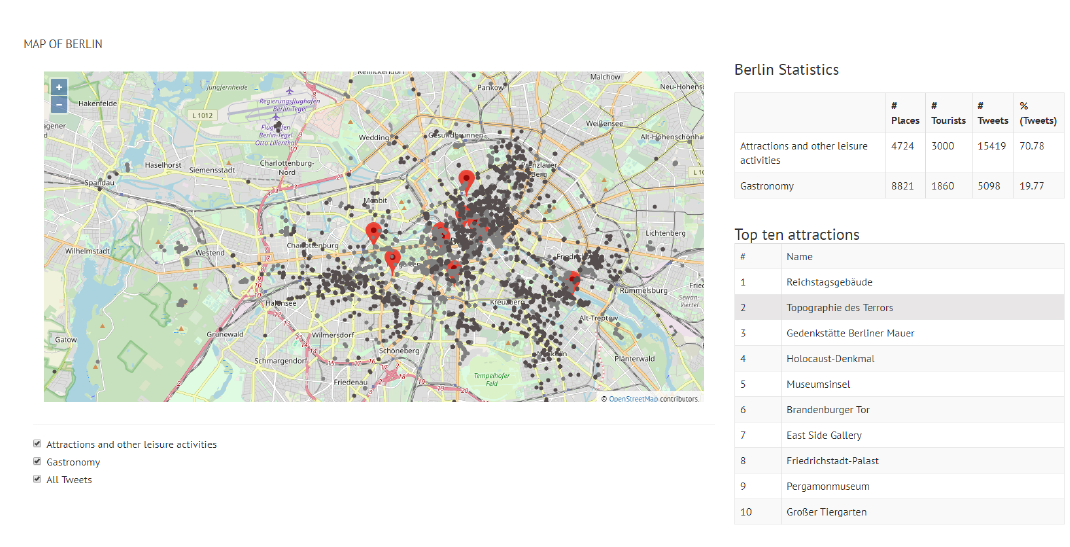
Figure 9. General view of Valencia.